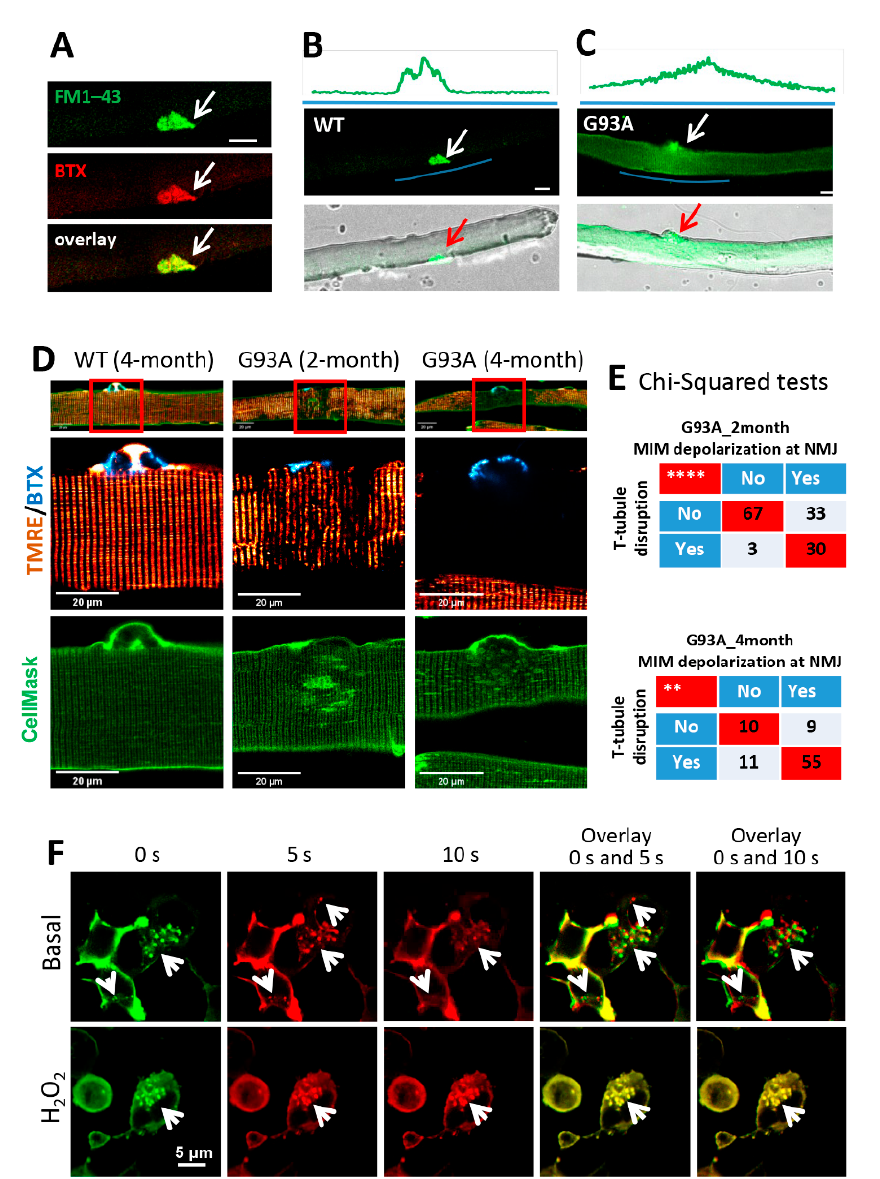
Figure 4. NMJ is more susceptible to injury than other regions of the sarcolemma, and mitochondrial dysfunction could underlie the impairment of the MG53-mediated membrane repair mechanism in G93A myofibers. ( A ) FM 1–43 and BTX co-localized at the NMJ of FDB myofibers (white arrows). ( B ) No intracellular FM 1–43 fluorescence was observed in the WT myofiber at 20 min after incubation with FM 1–43. ( C ) FM 1–43 entered the G93A myofiber via the NMJ region. Green line highlights the region for fluorescence intensity profiling. Scale bars: 20 µ m. ( D ) FDB myofibers were loaded with BTX (cyan), TMRE (red), and CellMask (green) simultaneously. At the site of NMJ, mitochondria depolarization (loss of TMRE fluorescence) occurred in myofibers derived from both 2-month-old and 4-month-old G93A mice, accompanied by disrupted T-tubule network (marked by CellMask). Normal mitochondria and organized T-tubule network were detected at the site of NMJ of WT myofiber. Scale bar: 20 µ m. ( E ) Chi-square tests indicate positive correlations between mitochondrial inner membrane (MIM) depolarization and T-tubule disorganization at the site of NMJ of G93A mice at both 2 months and 4 months of age (** p < 0.01, **** p < 0.0001, 3 mice/group). ( F ) The representative time-lapse images of C2C12 cells with overexpression of GFP–MG53 in the presence and absence (basal) of 1 mM H 2 O 2 . The overlay images were generated using images at 0 s and 5 s, or 0 s and 10 s. White arrows indicate GFP–MG53 vesicles. Scale bars: 5 µ m. 3.4. Mitochondrial Dysfunction Is Associated with the Disruption of Cell Membrane Integrity at NMJs of the ALS Muscle In skeletal muscle, the cell surface membrane travels deep into the myofibril-forming transverse tubules (T-tubules). Freshly isolated FDB myofibers were incubated with α –